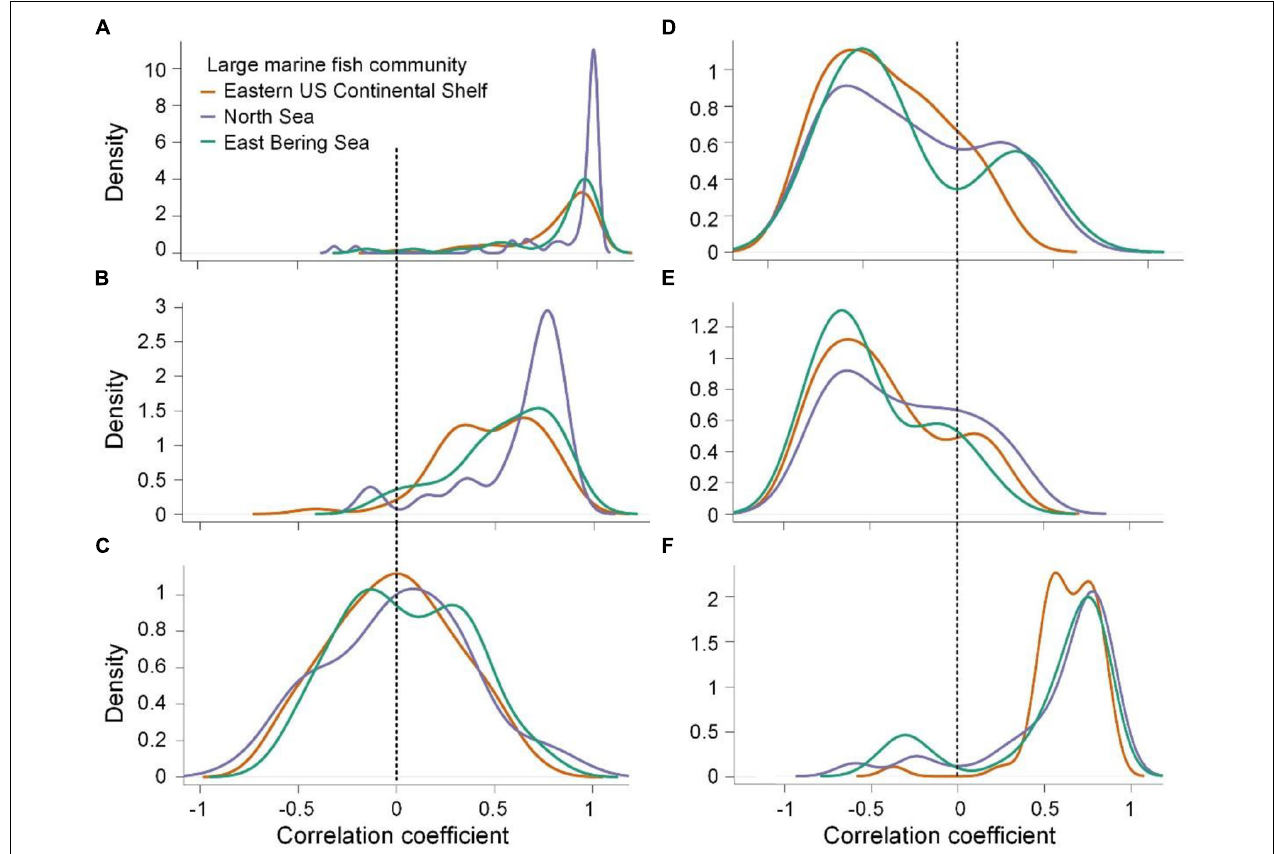
FIGURE 3 | Density distributions of correlation coefficients between species’ mean spatial robustness and species’ range sizes (A) , the number of interacting species (B) , median overlap proportion with interacting species (C) , correlation coefficients between species’ mean spatial sensitivity and species’ range sizes (D) , number of interacting species (E) , and median overlap proportion with interacting species (F) in the Eastern US Continental Shelf (orange), North Sea (purple), and Eastern Bering Sea (green). The vertical dashed lines indicate correlations equal to 0.